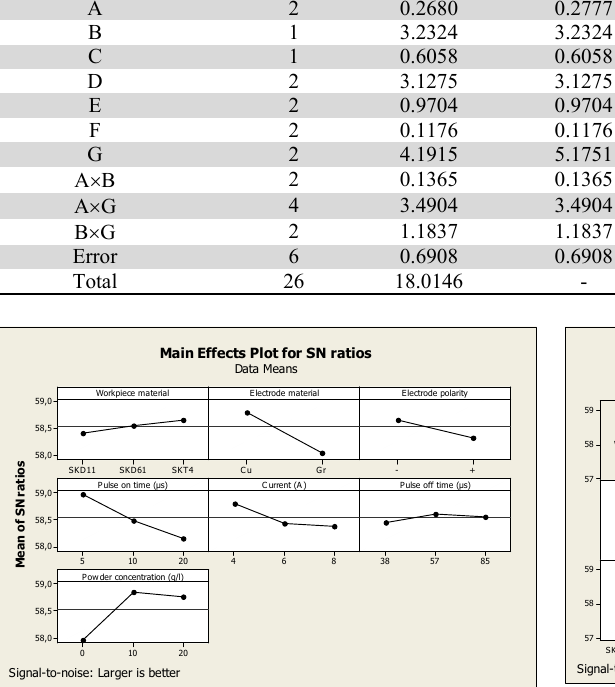
Fig. 3. Influence of interactive pairs on